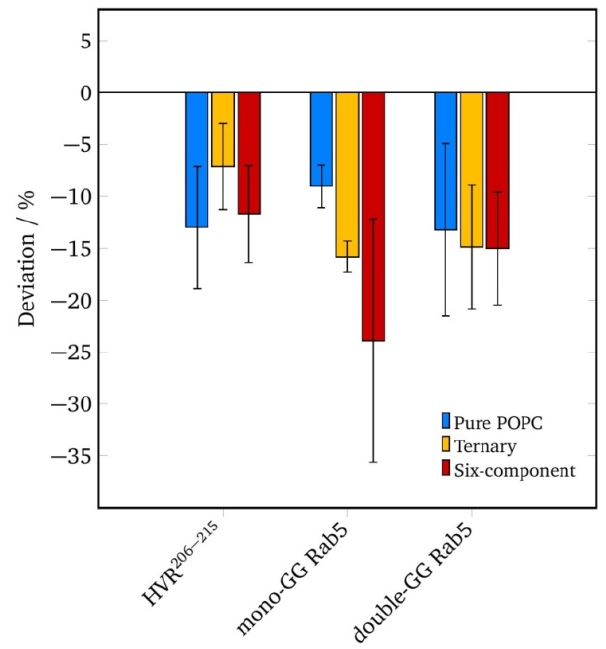
Figure 3. Variation of the average acyl chain order parameter in vicinity to the GG anchor (in a cutoff radius = 0.5 nm) from the global average in the three investigated membrane models for different protein systems.